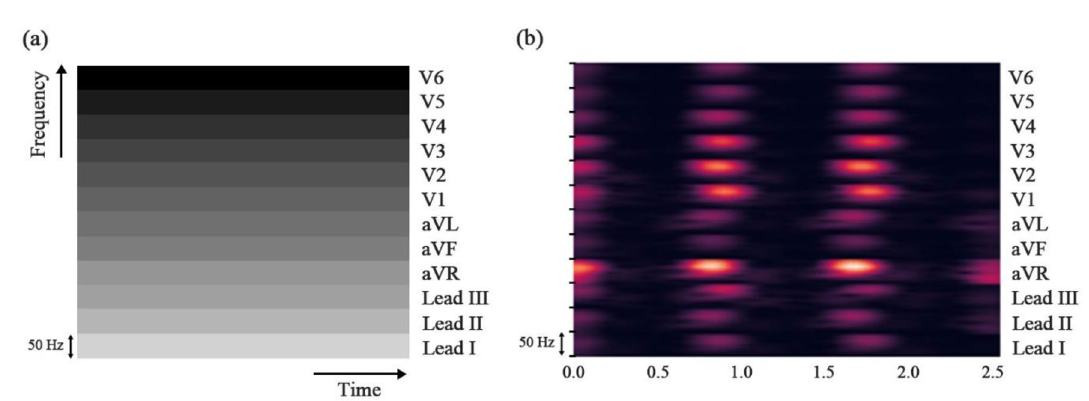
Figure 4. Time–frequency feature map. ( a ) Mimetic diagram of the time–frequency feature map; ( b ) a time– frequency feature map generated from the proposed